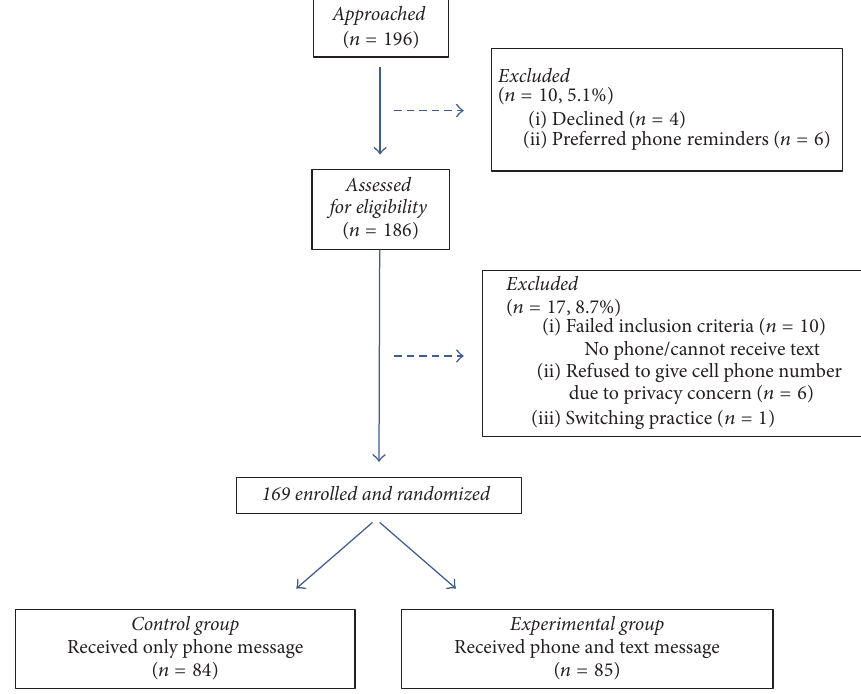
Figure 1: Flow chart of